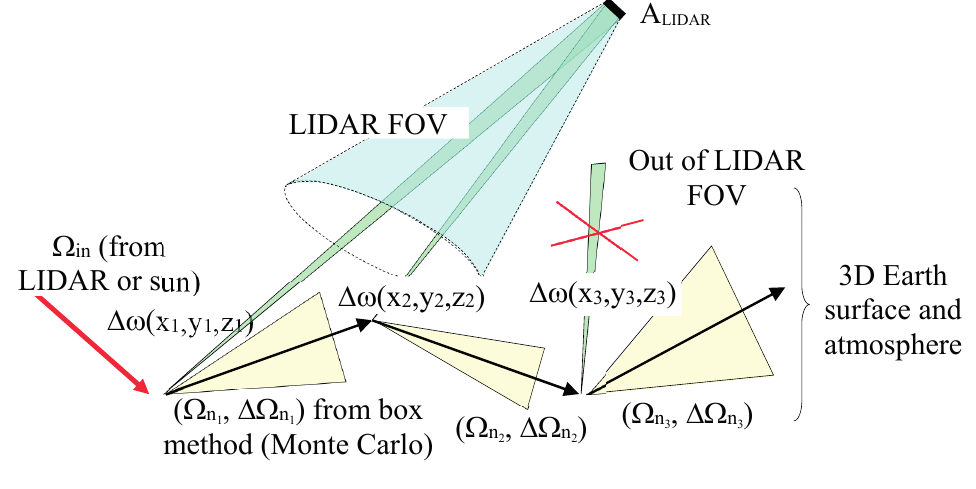
Figure 12. The Ray-Carlo approach for LIDAR simulation, depicted with all several scattering